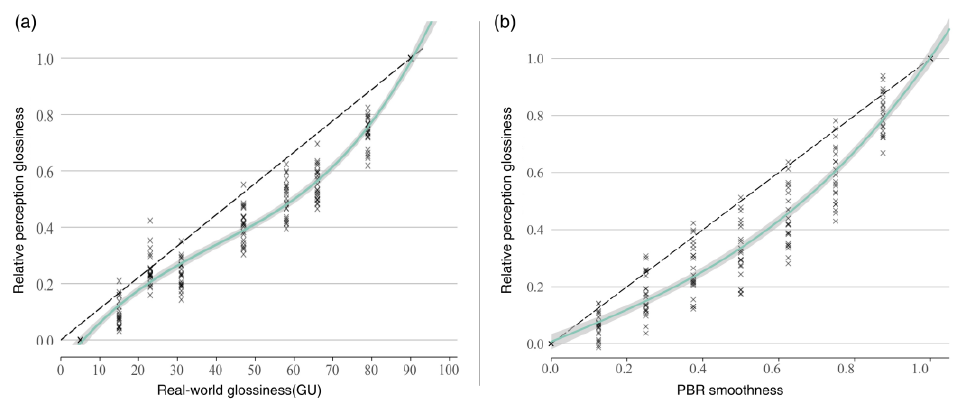
Figure 4. The results of the polynomial regression analysis. ( a ) depicts the relationship between gloss units (GU) measured in the physical world and the psychophysical measure of glossiness. ( b ) depicts the relationship between the PBR smoothness parameter in VR and the psychophysical measure. The black “x” markers signify the original experimental data obtained from distinct participants.